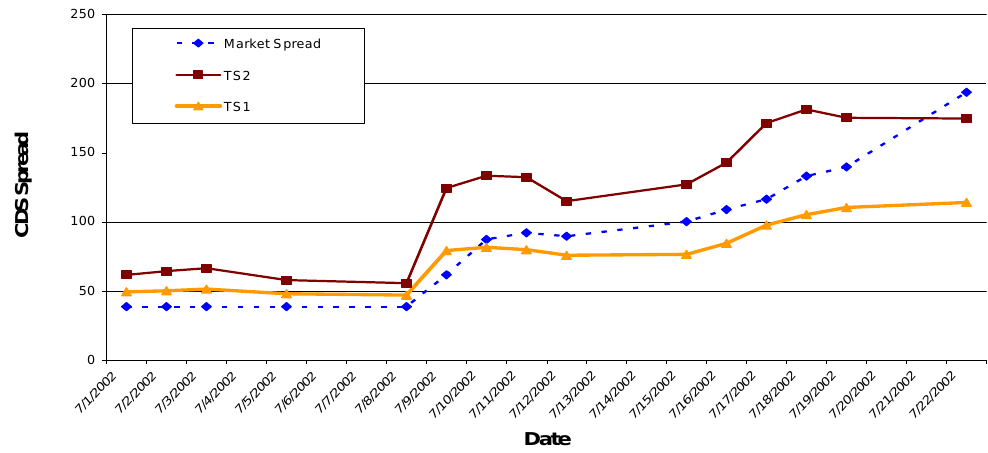
Figure 4. Wyeth, Bad News, CDS spread, TS2 vs. TS1. Figure 4 shows the dynamics of market CDS spread, TS2 modeled CDS spread, and TS1 modeled spread between 1 July to 23 July 2008. The market spread, TS1 and TS2 model spreads are all at a low level around 50 basis point. On 9 July the market CDS spread increases substantially. TS2 soars upward, far above market CDS spread, giving a strong signal that market CDS spread will increase further. The large difference between TS2 and market CDS spread sparks a trading signal. This trading signal turns out to be profitable—on 22 July when the TS2 spread and market CDS spread converge, the market CDS spread has more than tripled, and the arbitrageur who uses TS2 to trade would have profited. TS1 spread, on the other hand, does not generate any trading signals and the arbitrageur who carries out TS1 would have missed the opportunity. TS1 spread rises a little higher than market CDS spread on 9 July and then drops below the market CDS spread until the trade initiated by TS2 is liquidated.